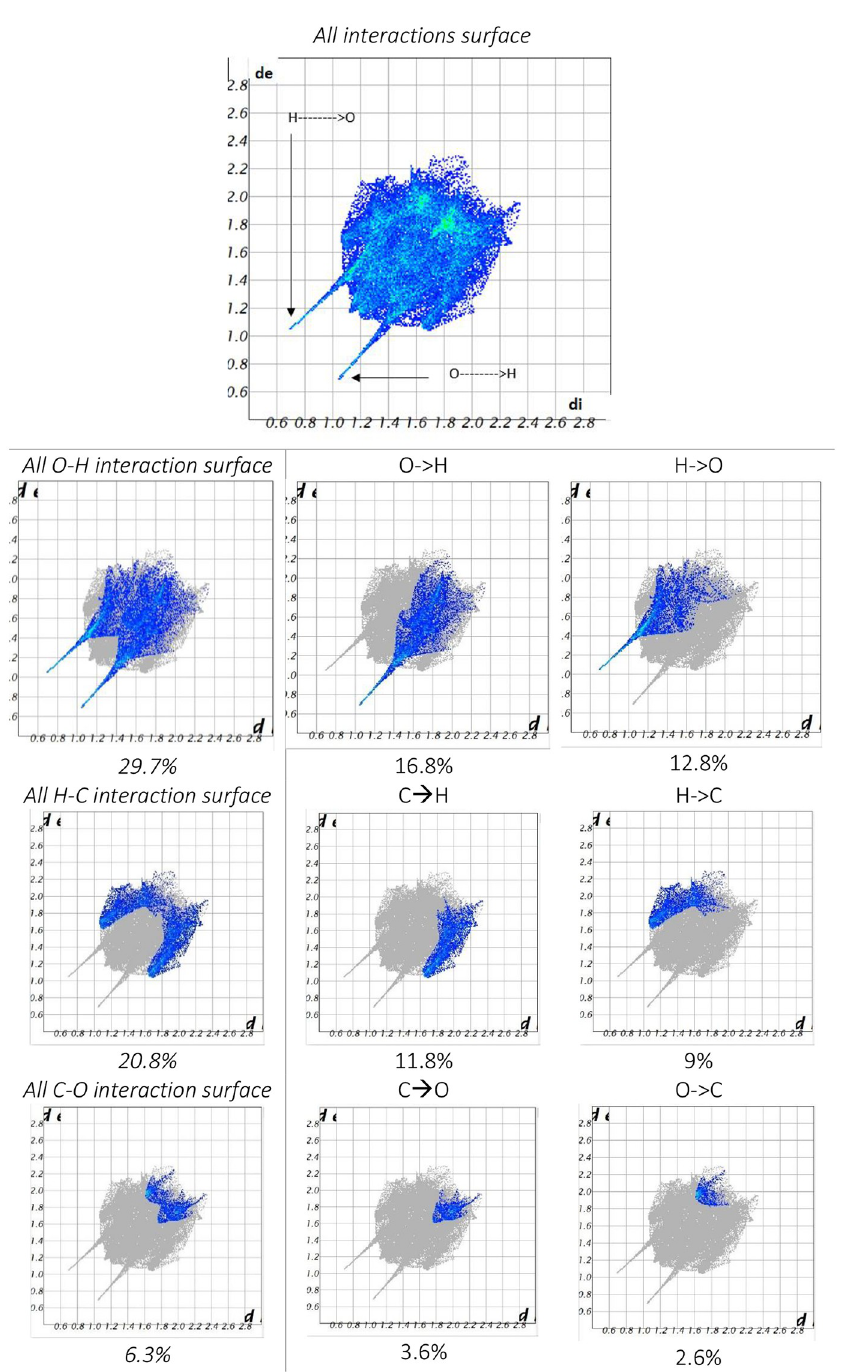
Fig 3. Atom-atom interactions and their contribution to the Hirshfeld surface.